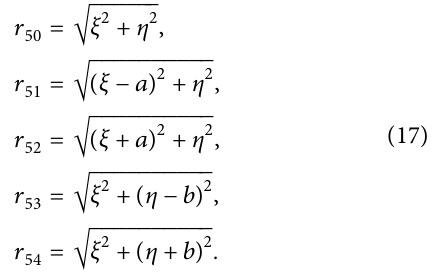
Figure 2: Graph of P ( α )